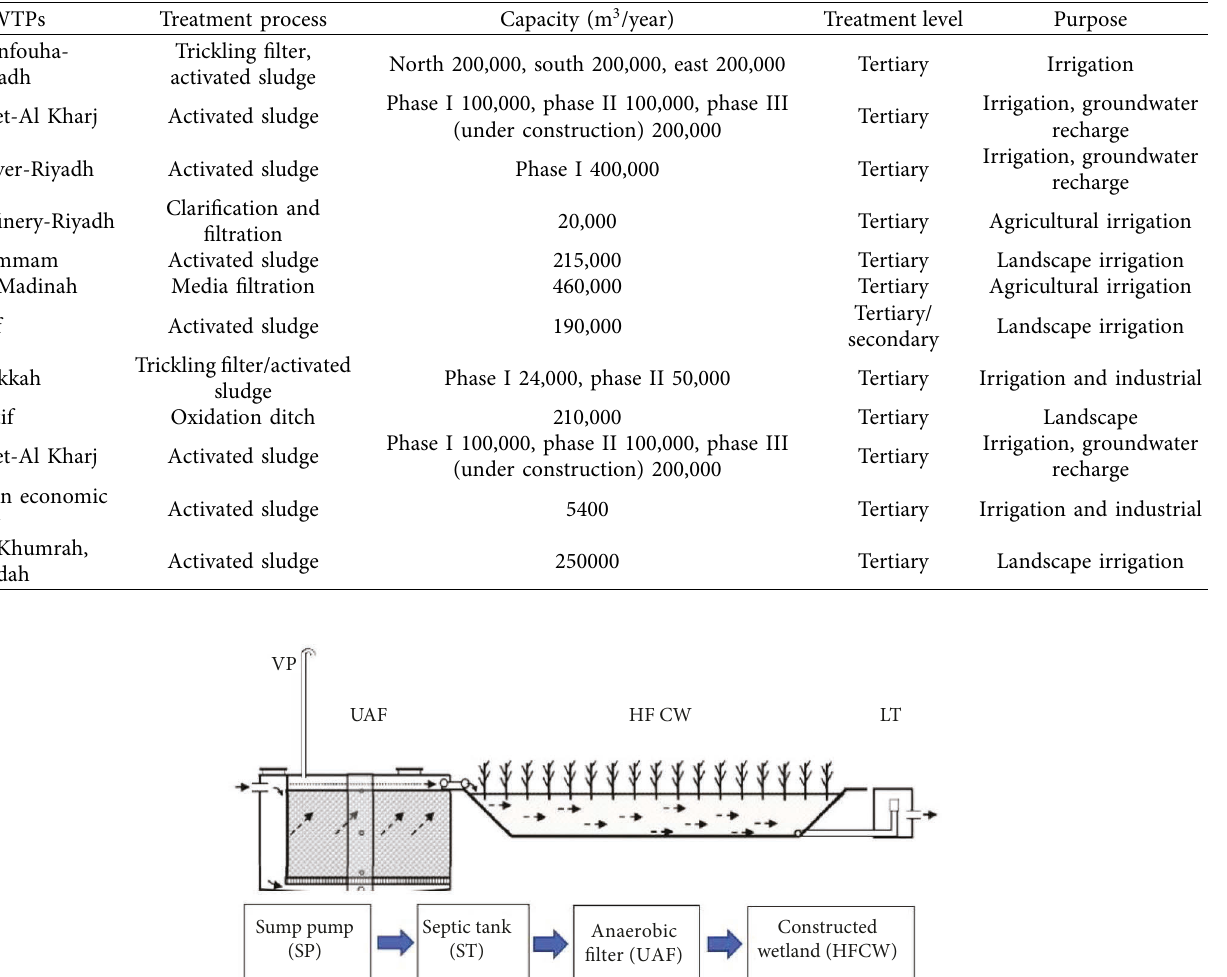
Table 2: Wastewater treatment plants, working mechanism, and capacity in Saudi Arabia.